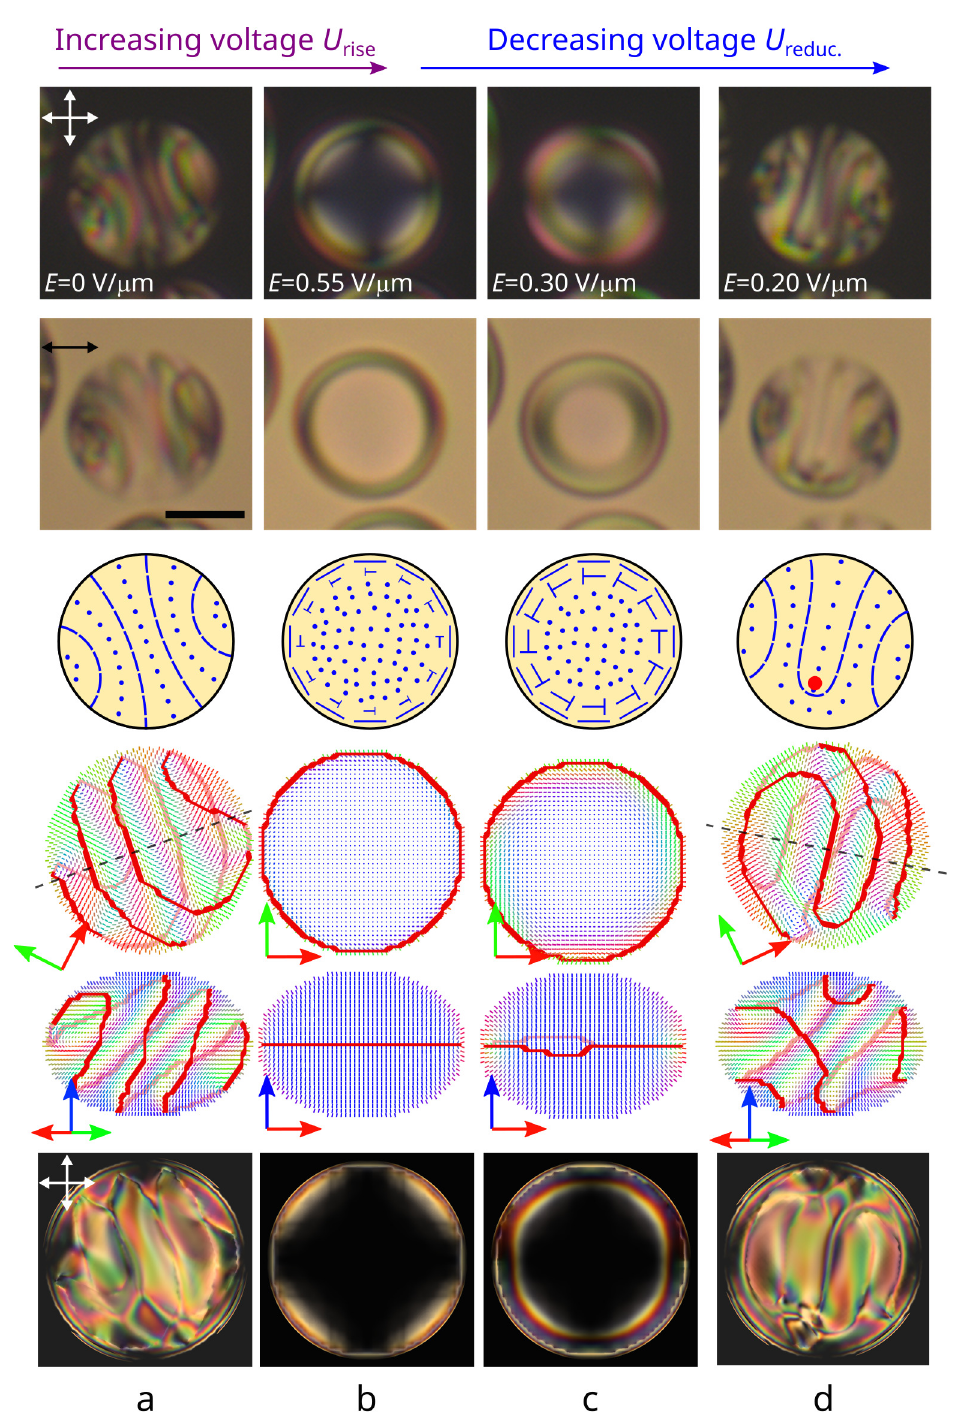
Figure 2. The initial N 0 = 7.7 structure with a bipolar distribution of the cholesteric axis ( a ), droplet under an electric field E rise equal to 0.55 V/ µ m ( b ) when voltage increases. The droplet under an electric field E reduc . equal to 0.30 V/ µ m ( c ) and 0.20 V/ µ m ( d ) when voltage decreases. POM photos taken with the crossed polarizers ( top row ) and with one polarizer ( second row ); schemes of the director in the droplet cross-section ( third row ); calculated director distributions at the top view ( fourth row ) and side view ( fifth row ), and the corresponding POM pictures ( bottom row ). The red circle indicates the cross-section of the λ + 1/2